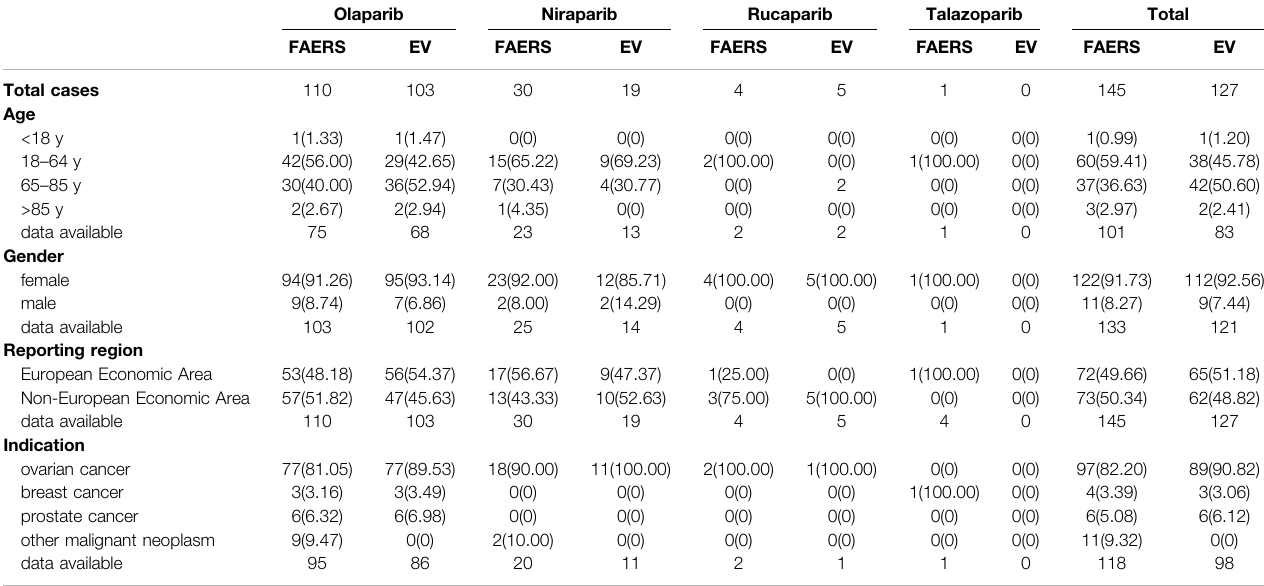
TABLE 2 | The characteristics of AML reported by PARP inhibitors in FAERS and EV database.